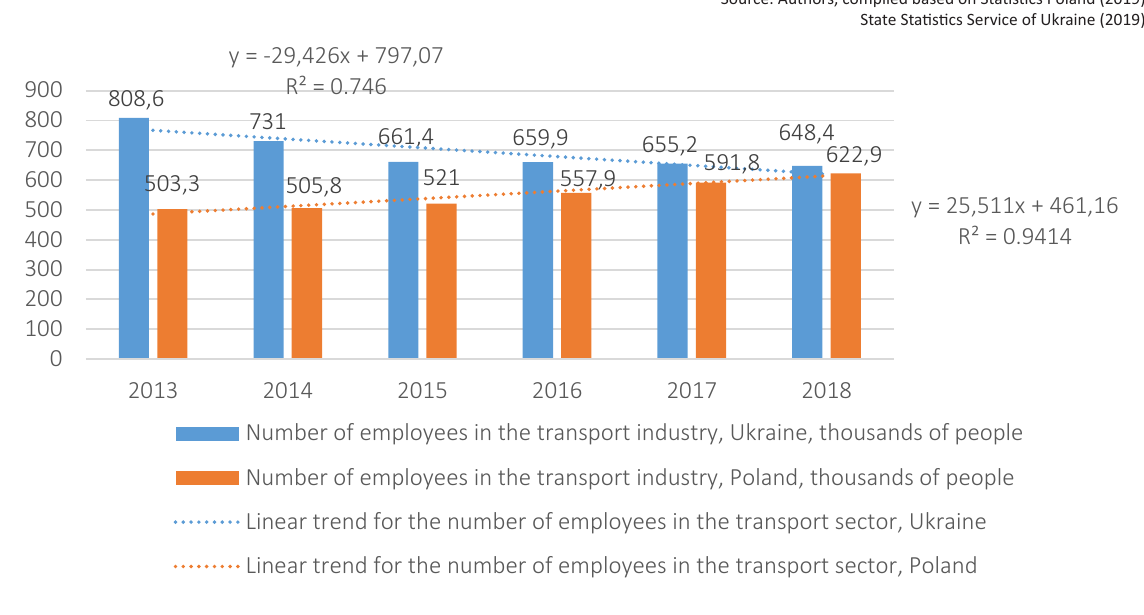
Figure 3. The dynamics of the number of employees in the transport industry during 2013–2018